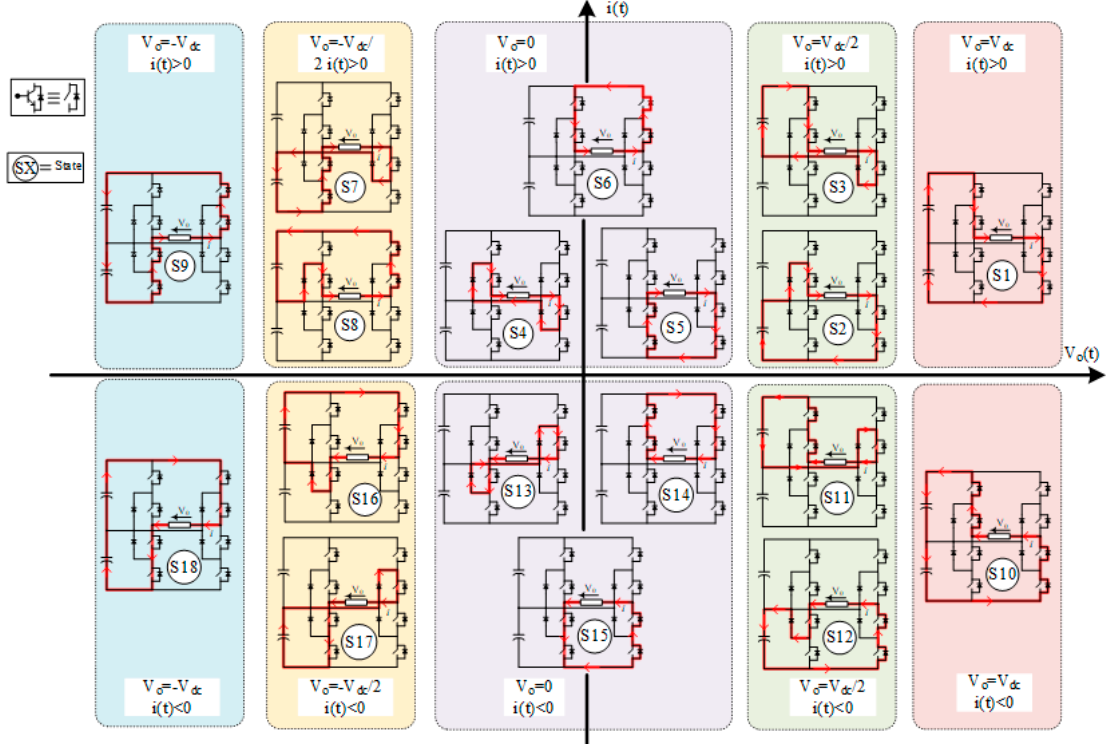
Figure 5. HB-5L-NPC converter configurations to generate the five voltage levels.